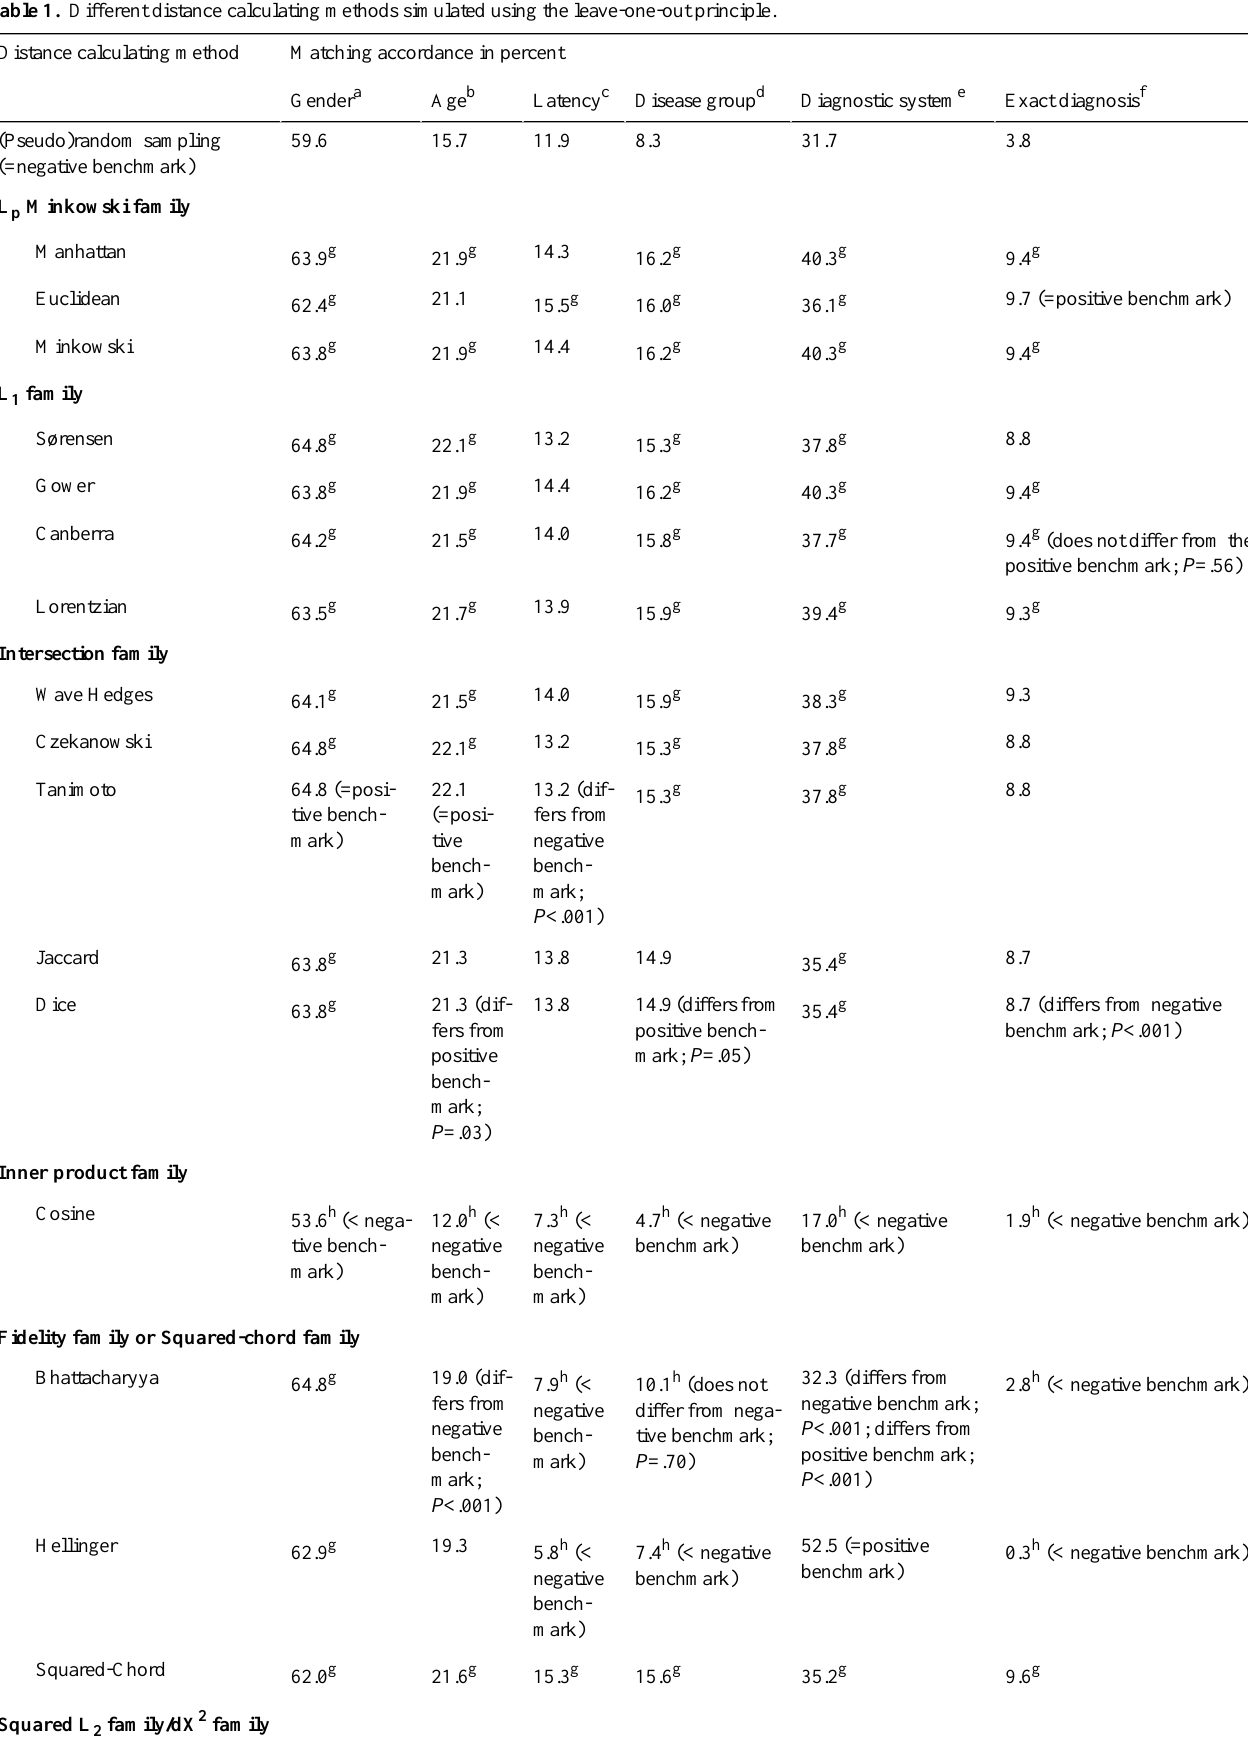
Table 1. Different distance calculating methods simulated using the leave-one-out principle. Matching accordance in percentDistance calculating